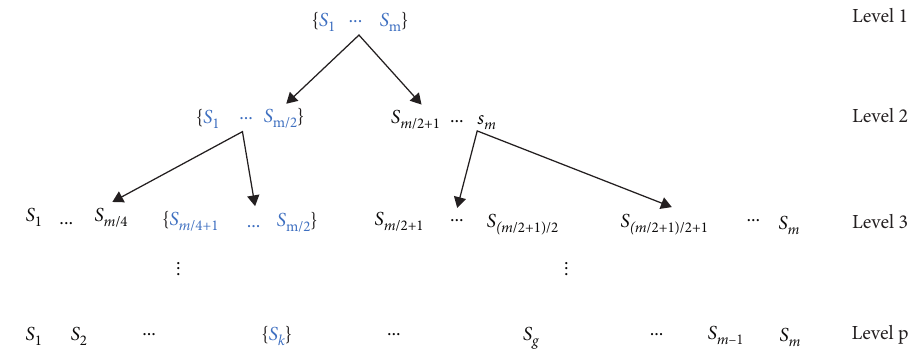
Figure 3: HPD detection depth